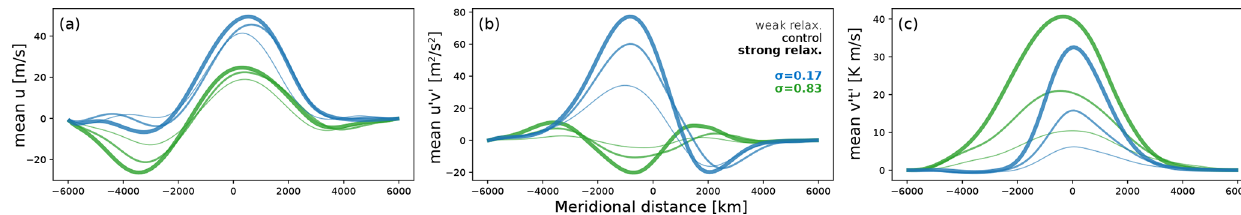
Figure 6. Sensitivity of the full PE storm track to the strength of temperature relaxation. The panels (a–c) here correspond to panels (a), (b) and (d) in Fig. 5, with the control simulation here being identical to the PE simulation there. Line colour and weight is consistent across